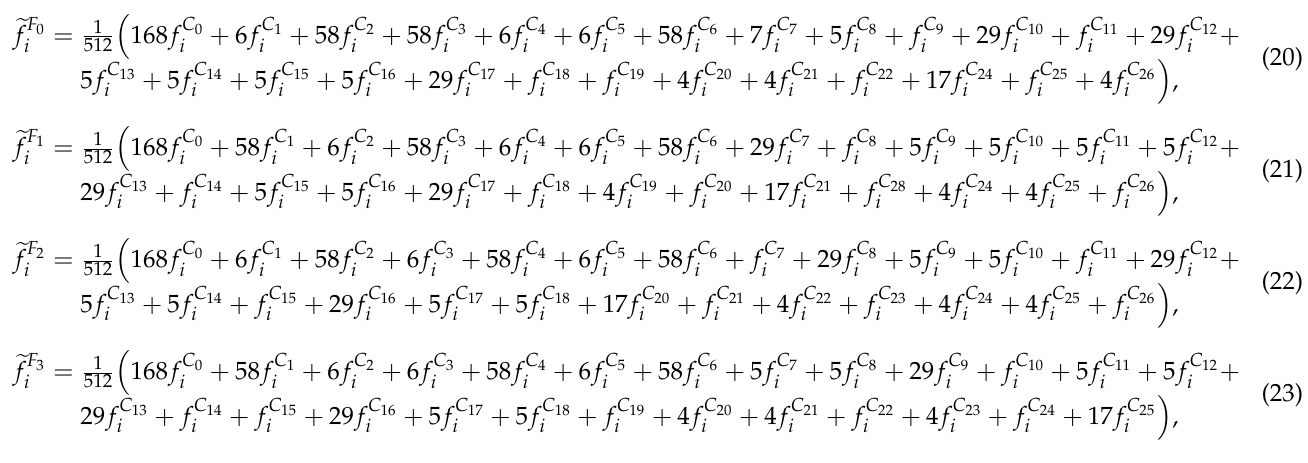
Figure 9. Schematic diagram of the coarse and fine grids in 3D. The distribution functions of eight grids F i ( i = 0, 1, . . . , 7 ) are obtained by interpolating the distribution functions on the 27 coarse grids C i (i = 0, 1, 2, . . . , 26). The specific format is as follows: